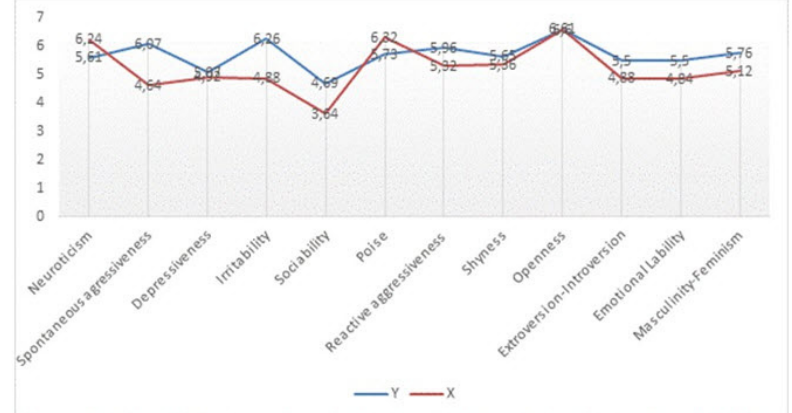
Figure 2. Expression of personality traits in generation